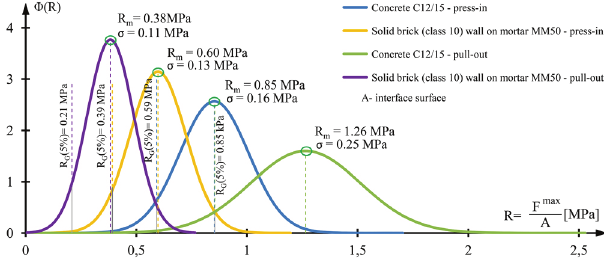
Fig. 19. Probability distribution of strength